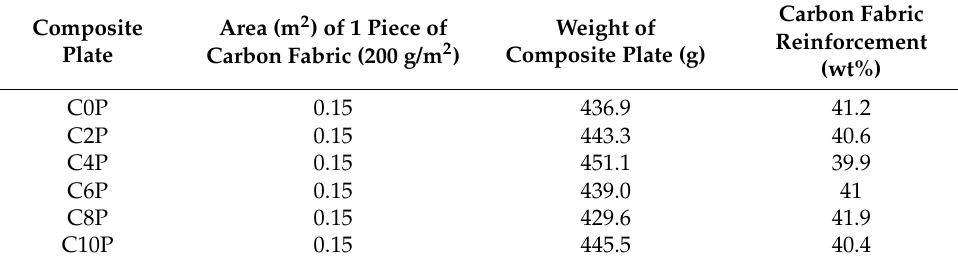
Table 2. The percentage of filling of prepared composite